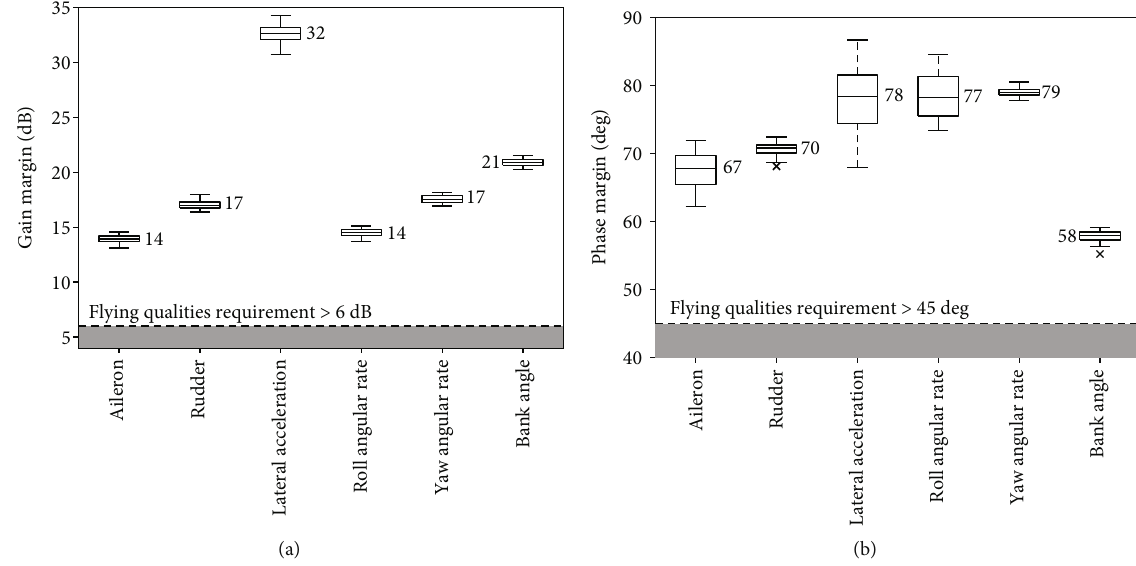
to a response. (b) ϕ to a response. (c) a yc y y c to ϕ response. (h) ϕ to ϕ response. yc c